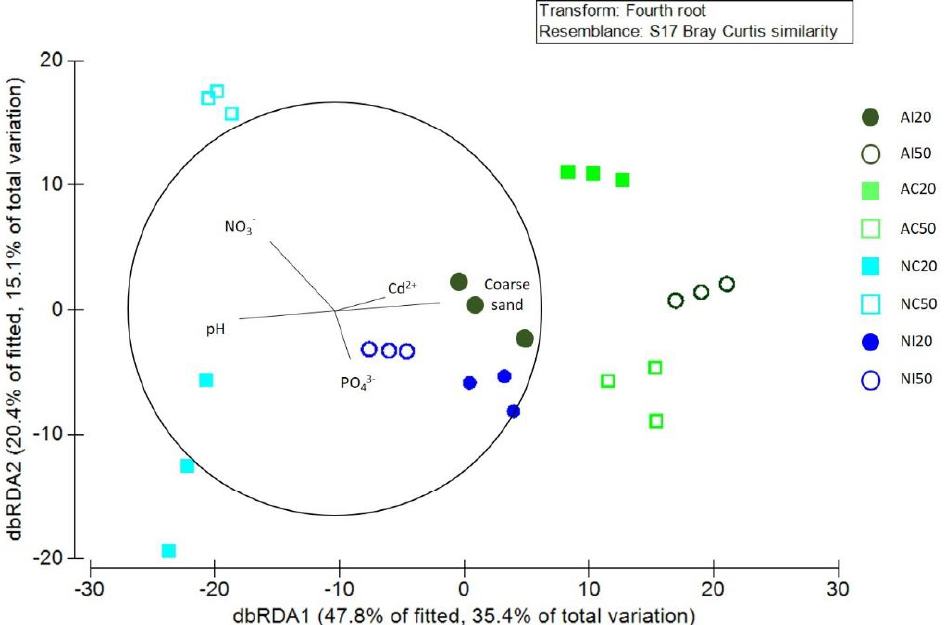
Figure 8. The dbRDA (distance-based redundancy analysis) ordination of total meiobenthic assemblages vs. the significant explanatory environmental variables selected by distLM. Vector overlays represent multiple partial correlations of the explanatory variables with the distance-based redundancy analysis (dbRDA) axes. See text for further explanation. DistLM performed on rare assemblage structures of the selected TOC, Cu 2+ , pH, NO 3¯ ,